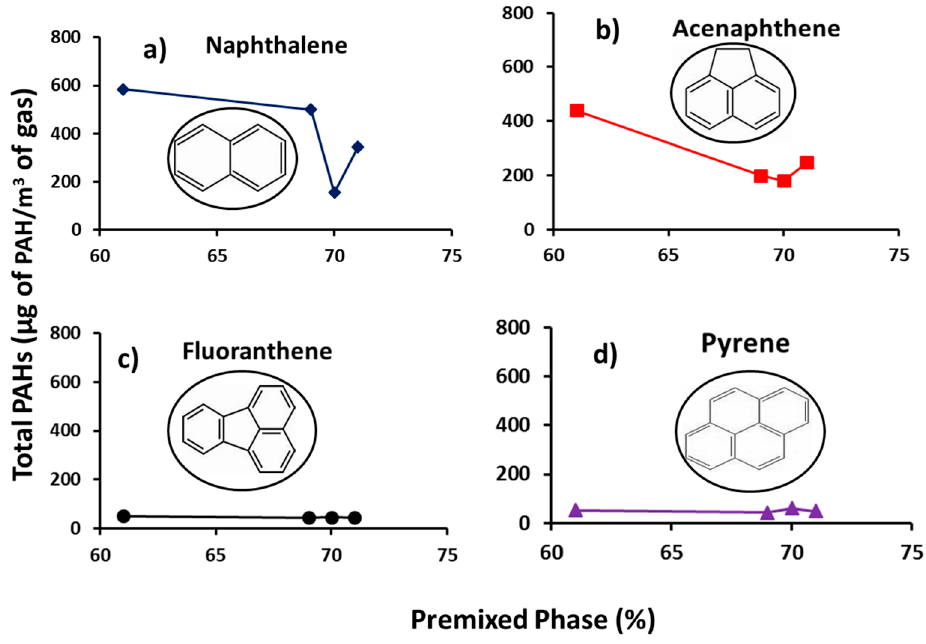
Figure 6. Profiles of Group D individual total PAH ( µ g PAH / m 3 gas) with premixed phase (%) ( a ) naphthalene, ( b ) acenaphthene, ( c ) fluoranthene and ( d ) pyrene.